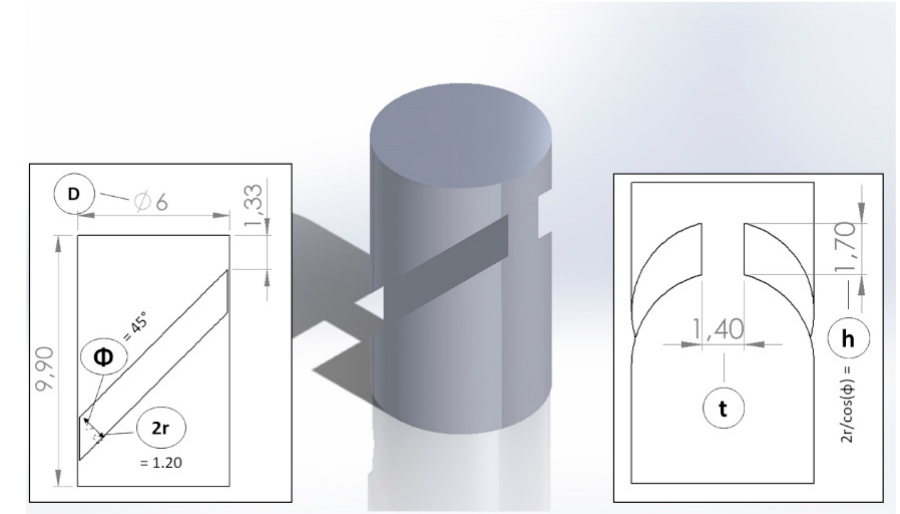
Figure 3. The shear compression specimen (SCS) geometry used in the present work (dimensions in mm).